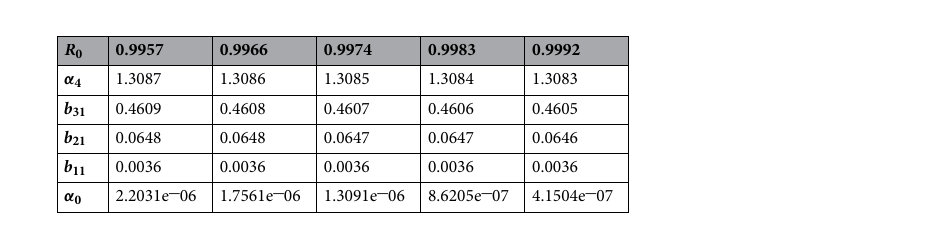
Table 4. Values of the first column of the Routh table when R 0 < 1